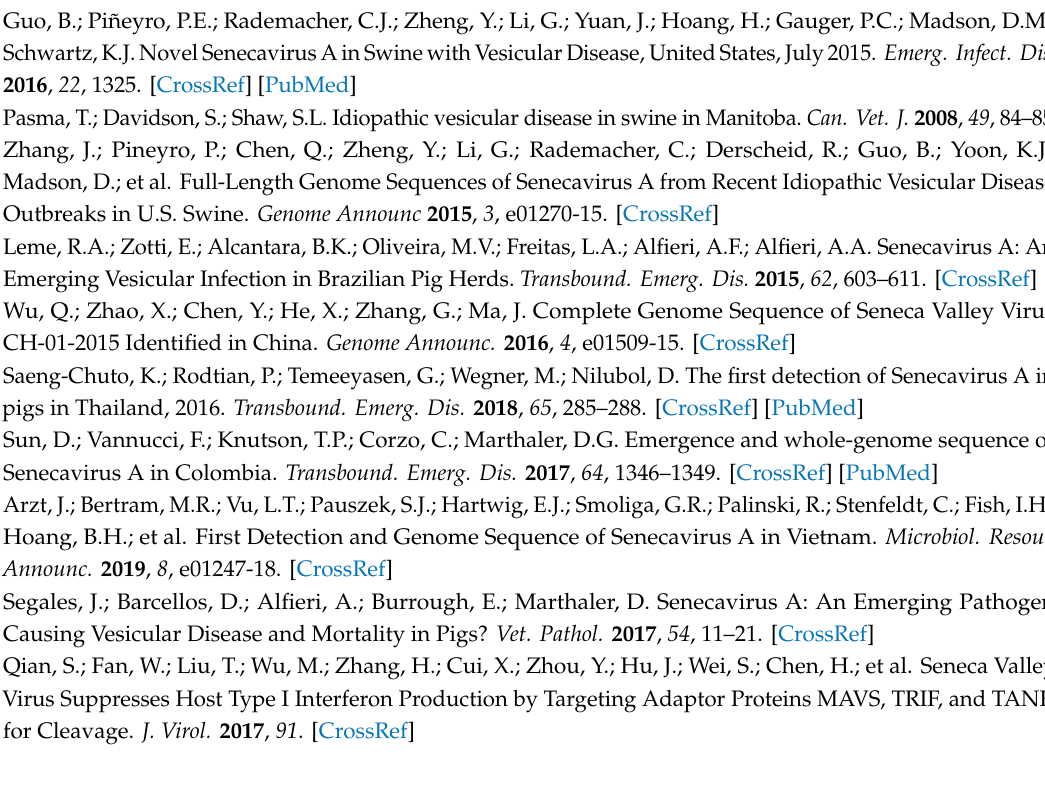
Figure S1: Zetasizer Nano measurements of Pentamer and SVA